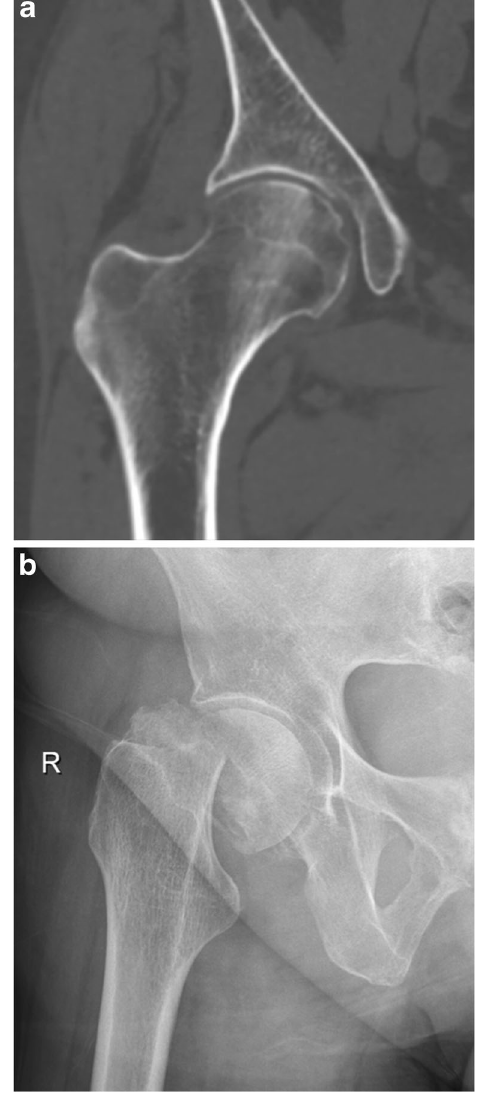
Fig. 12 Subcapital insufficiency fracture of the right femur in a 77-year- old woman with stage IIIB non-small cell lung cancer. The patient developed extensive radiation pneumonitis, which was treated with high-dose glucocorticoids for 1 year, probably causing a greater rate of bone loss with subsequent insufficiency fracture. a Coronal non- enhanced CT image in bone window, performed 1 month prior to the fracture, shows no signs of metastatic bone involvement in the right hip. b Supine X-ray of the right hip shows a subcapital fracture of the right femur without associated osteolytic bone destruction. Absence of malignancy was confirmed on histopathological examination of the femoral head after total hip